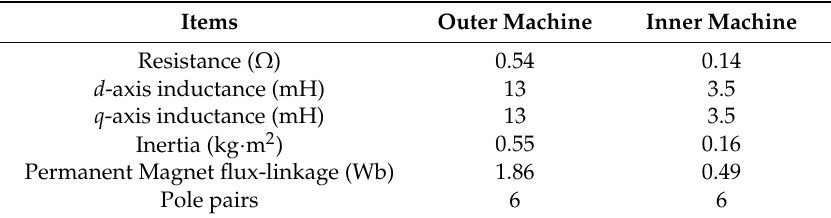
Table 2. Parameters of the EVT